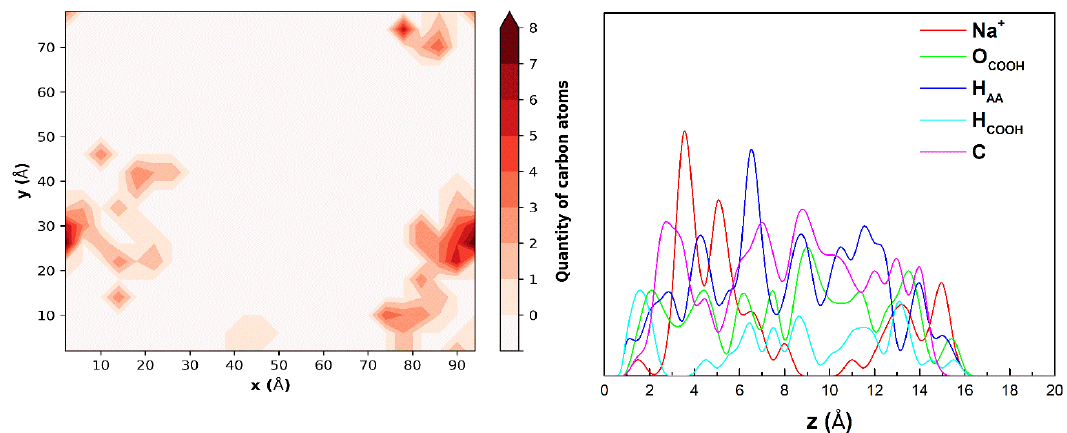
Figure 3. The contour map for 36.35 ps clearly shows the grouping of carbon atoms that make up the acrylic acid molecules (Figure 3a). Similar groupings are visible for 52.90 and 63.00 ps. The atom quantity graphs as a function of distance from the surface of the montmorillonite layer (Figure 3b) show that the atoms that make up acrylic acid and Na + are grouped at distances up to 16.0(3) Å. Nearest to the surface of the layer are hydrogens atoms from the COOH group (H COOH ) at 1.2(3) Å and hydrogens bonded to carbon (H AA ) a bit further at 1.5(3). These atoms are much closer than the positively charged Na + compensating for the negative charge of the layer, which is the most frequent at about 3.5 Å. The oxygen molecules from the COOH group (O COOH ) are located a little further from the surface at about 2 Å. This shows that the molecules closest to the surface are directed to the surface with H COOH and H AA . Both contour maps and graphs of the number of atoms in the dependence of distance from the montmorillonite surface show little changes over time in the position of the atoms groupings and the arrangement of the atoms within the group. These changes are caused by the random thermal movement of the water molecules.